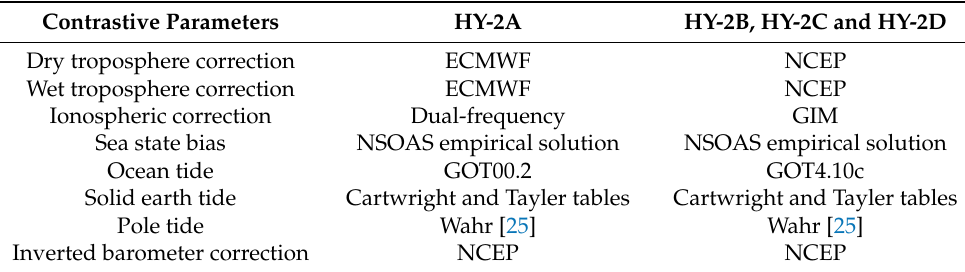
Table 1. List of parameters used to estimate the SSH for HY-2 series missions (ECMWF, NCEP and GIM are the European Centre for Medium-Range Weather Forecasts, National Centers for Environmental Prediction, and Global Ionospheric